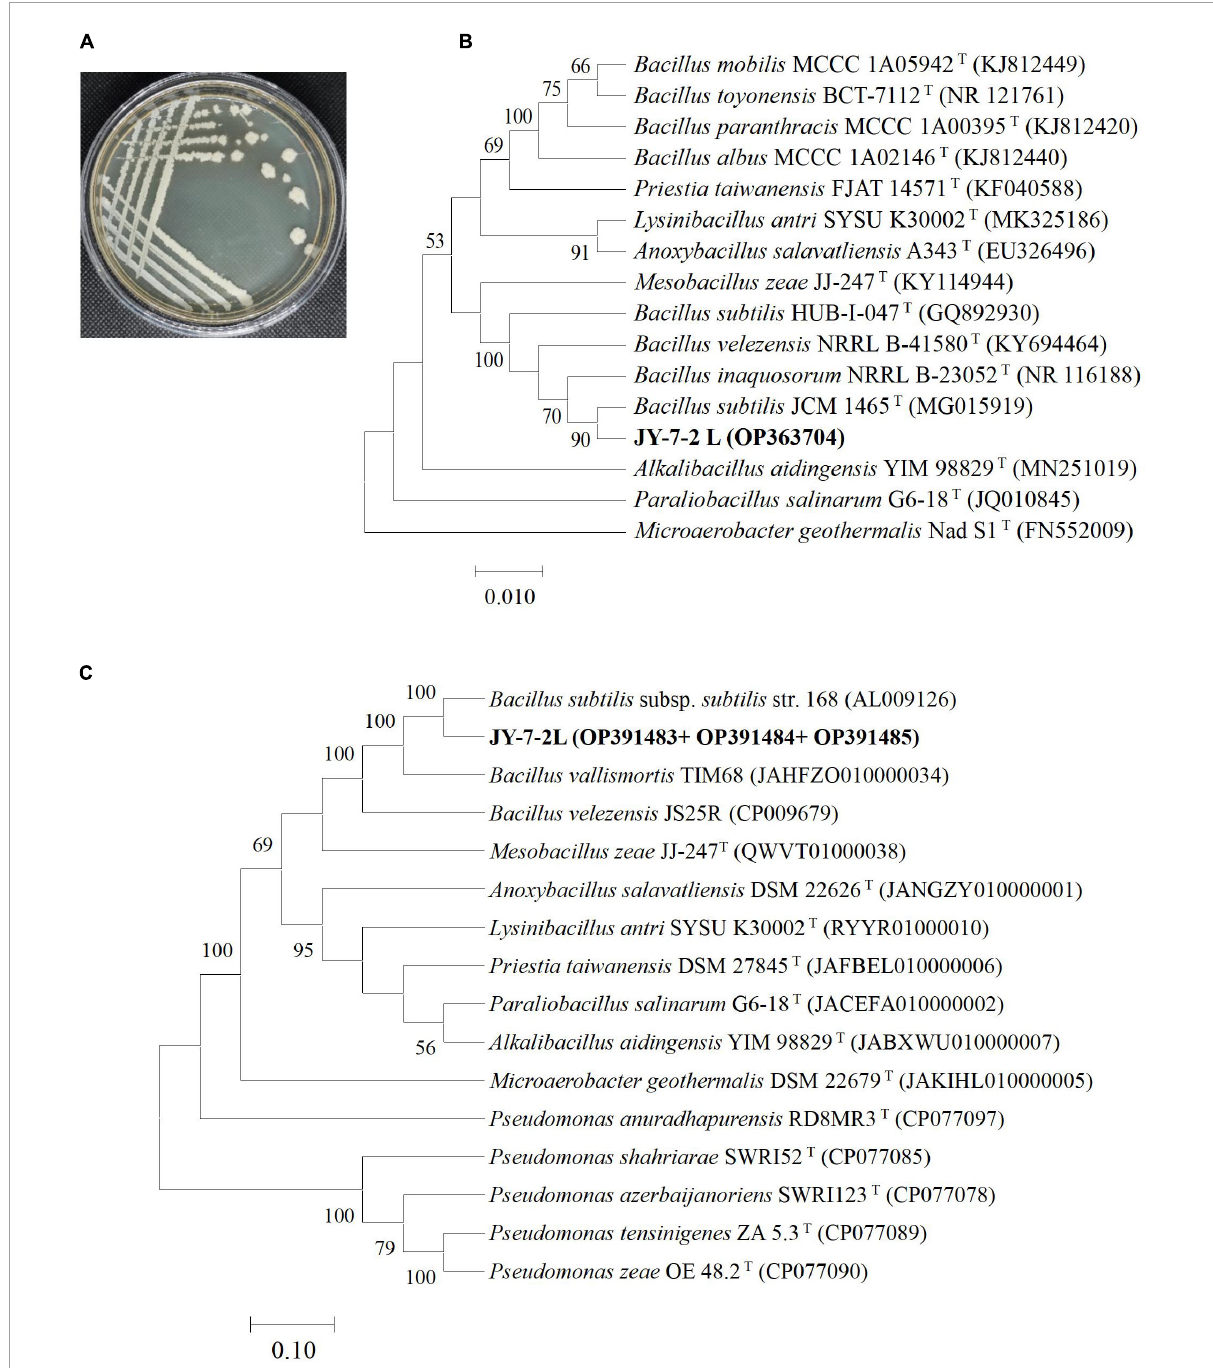
FIGURE1 Phylogenetic characterization of JY-7-2L. (A) Morphology of JY-7-2L on Luria-Bertani (LB) agar medium; (B) phylogenetic tree based on 16S rRNA gene; and (C) a concatenated alignment of atpD , gyrA , and rpoB gene sequences. The trees were constructed using the Neighbor-Joining method with 1,000 bootstrap replicates. A bootstrap value greater than 50% was shown on the branches. Accession numbers were indicated in